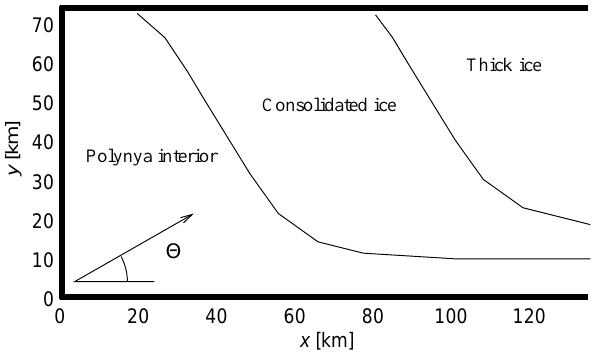
Fig. 3. The size of the basin (in km) and wind direction during the polynya experiments. The figure also shows the three ice regimes one expects; the polynya interior (where the ice is in free drift), consolidated ice and thick initial